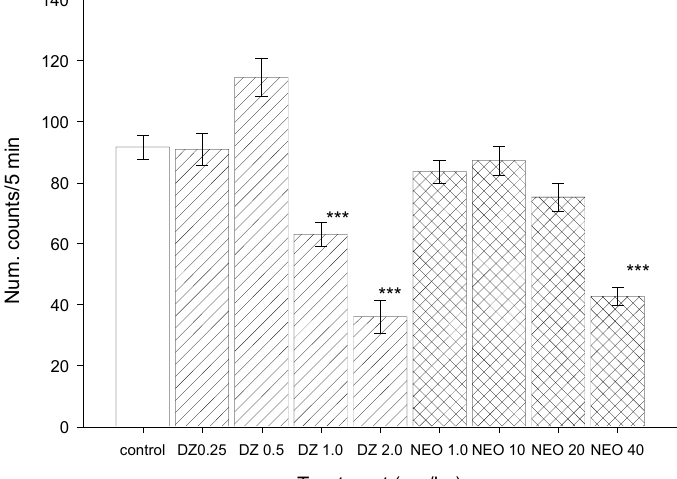
Figure 4. Effects of diazepam (DZ) and 2( S )-neoponcirin on locomotor